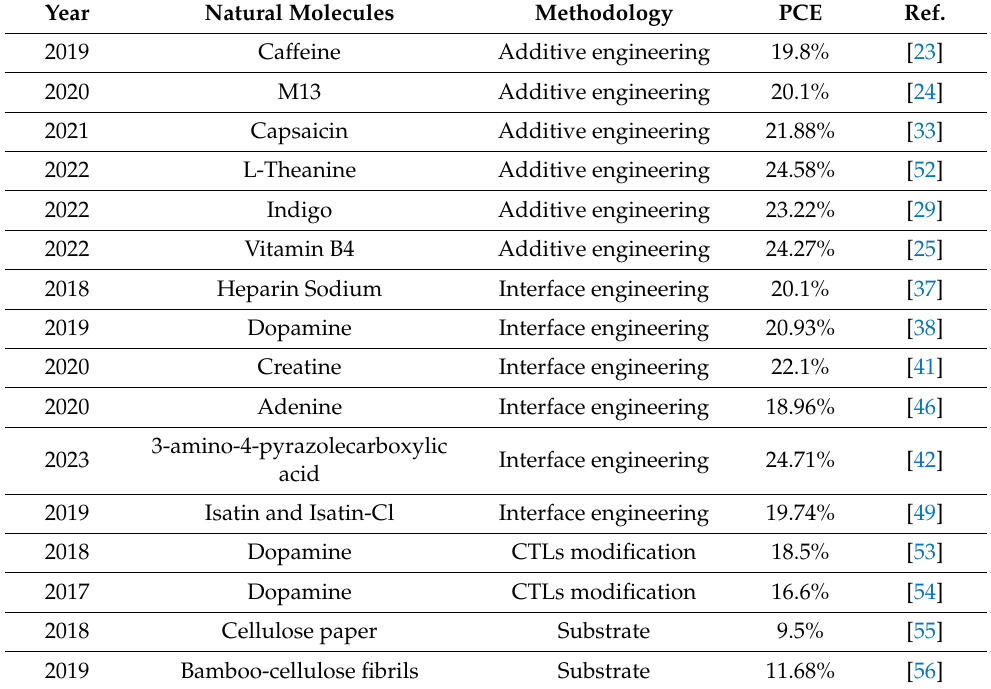
Table 1. Summary of natural molecules applied in